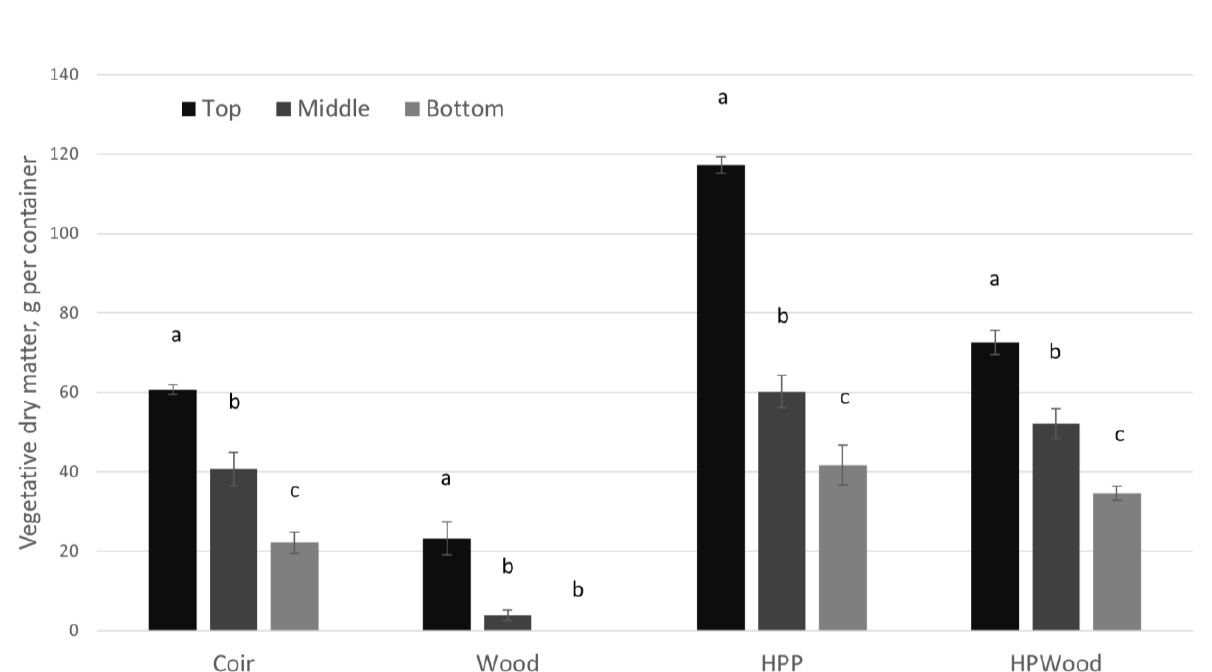
Figure 6. Aboveground vegetative dry matter per container in different substrates and levels in plant towers. Vertical bars represent ± SE (n = 6). Different lowercase letters indicate statistically significant differences between the levels within each substrate ( p < 0.05) by Tukey’s